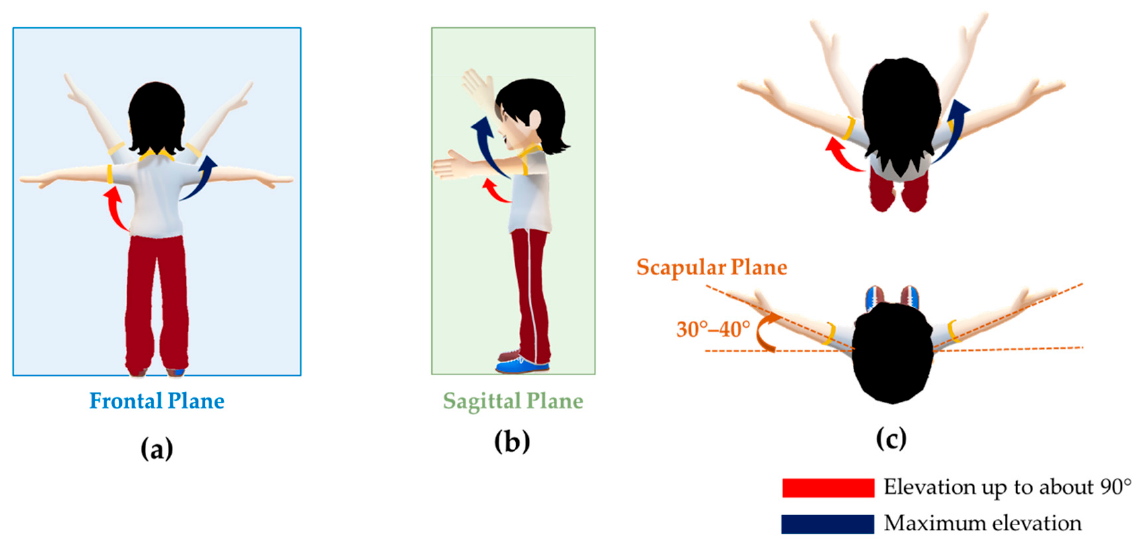
Figure 4. Experimental protocol: ( a ) elevation in the frontal plane; ( b ) elevation in the sagittal plane; ( c ) elevation in the scapular plane. The red and blue arrows represent the elevation up to 90° and the maximum elevation, respectively.